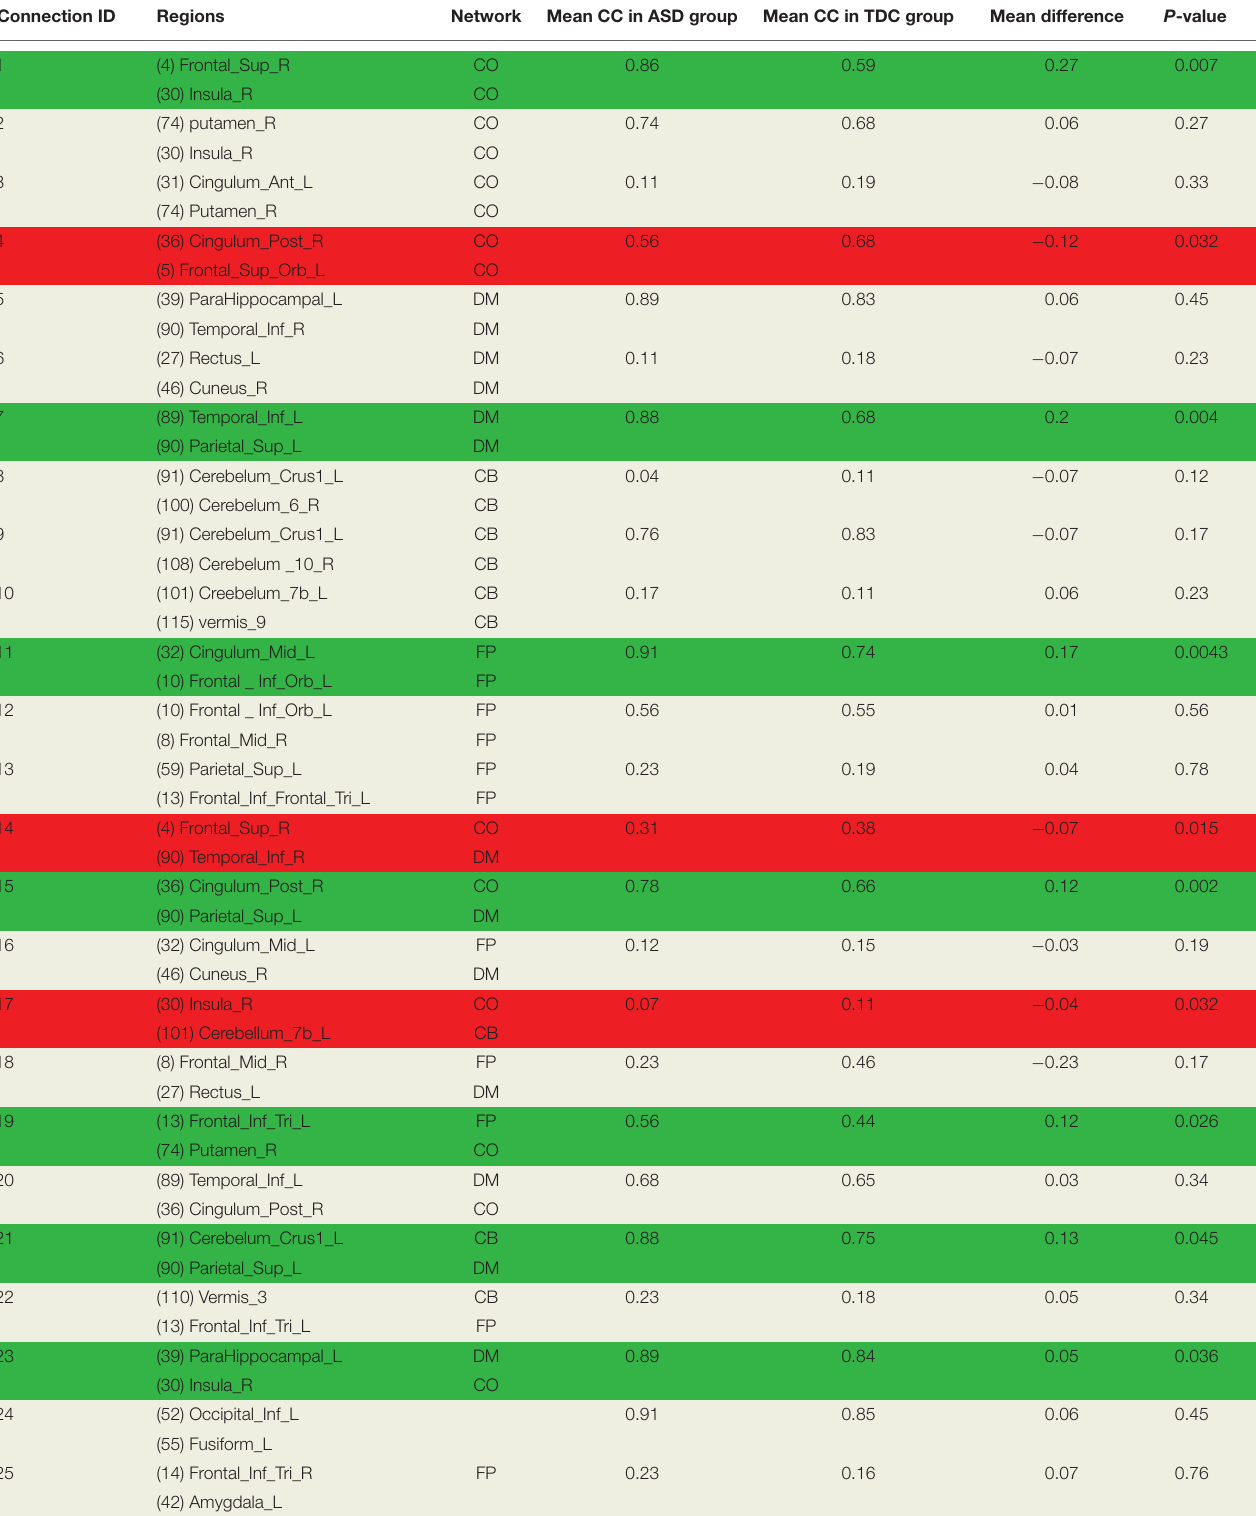
TABLE 6 | The network analysis of 32 most significant FC